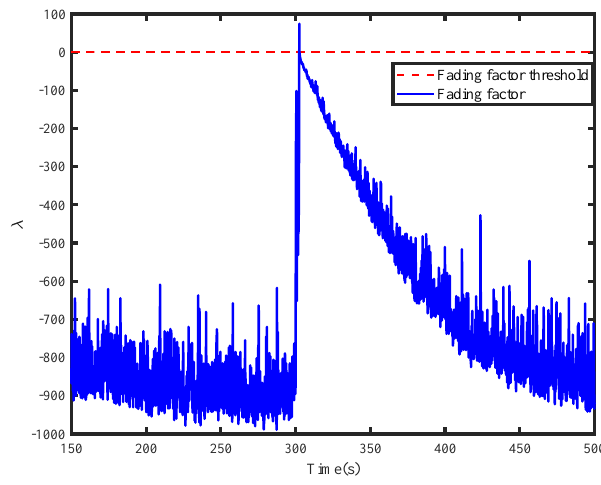
Figure 10. Fading Factors of the AWSTUKF.